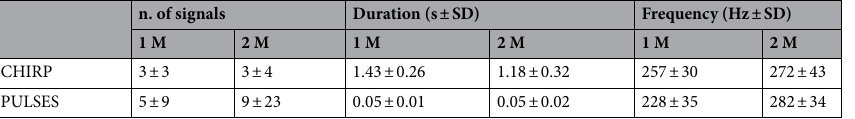
Table 2. Number of signals per individual and temporal and spectral parameters of GW male signals in exp.1 and exp.3. Means (± SD) are shown.